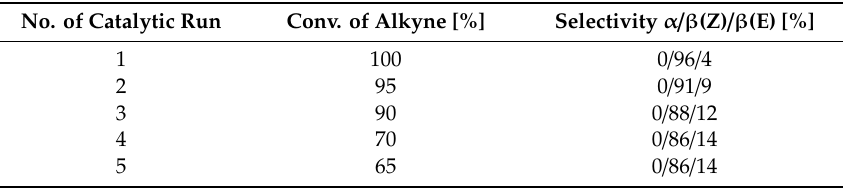
Table 3. The conversion and selectivity for hydrosilylation of 1-octyne with HMTS in subsequent catalytic runs catalyzed by the same portion of the catalyst 1 isolated from the post-reaction mixture by centrifugation.